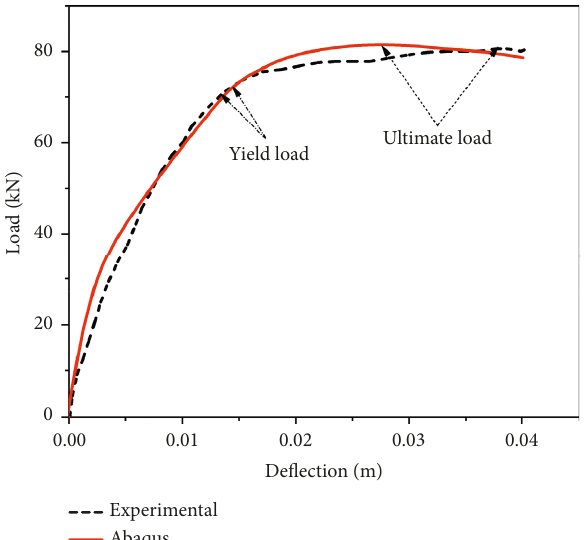
Figure 12: Comparison of the load-displacement response of the FEM and the experimental results of the control specimen at the beam-free